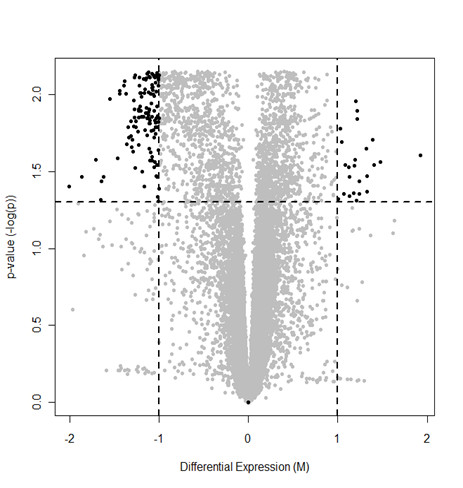
Volcano plot of the False Discovery Rate (FDR) corrected p-values from a t-test between the two sample groups after background subtraction and quartile normalization. Genes above the horizontal dashed line have p < 0.05 after FDR correction. It is evident that substantially more genes are significantly down-regulated (121 genes in upper left corner, > 2-fold) than up-regulated (24 genes in upper right corner, > 2-fold).